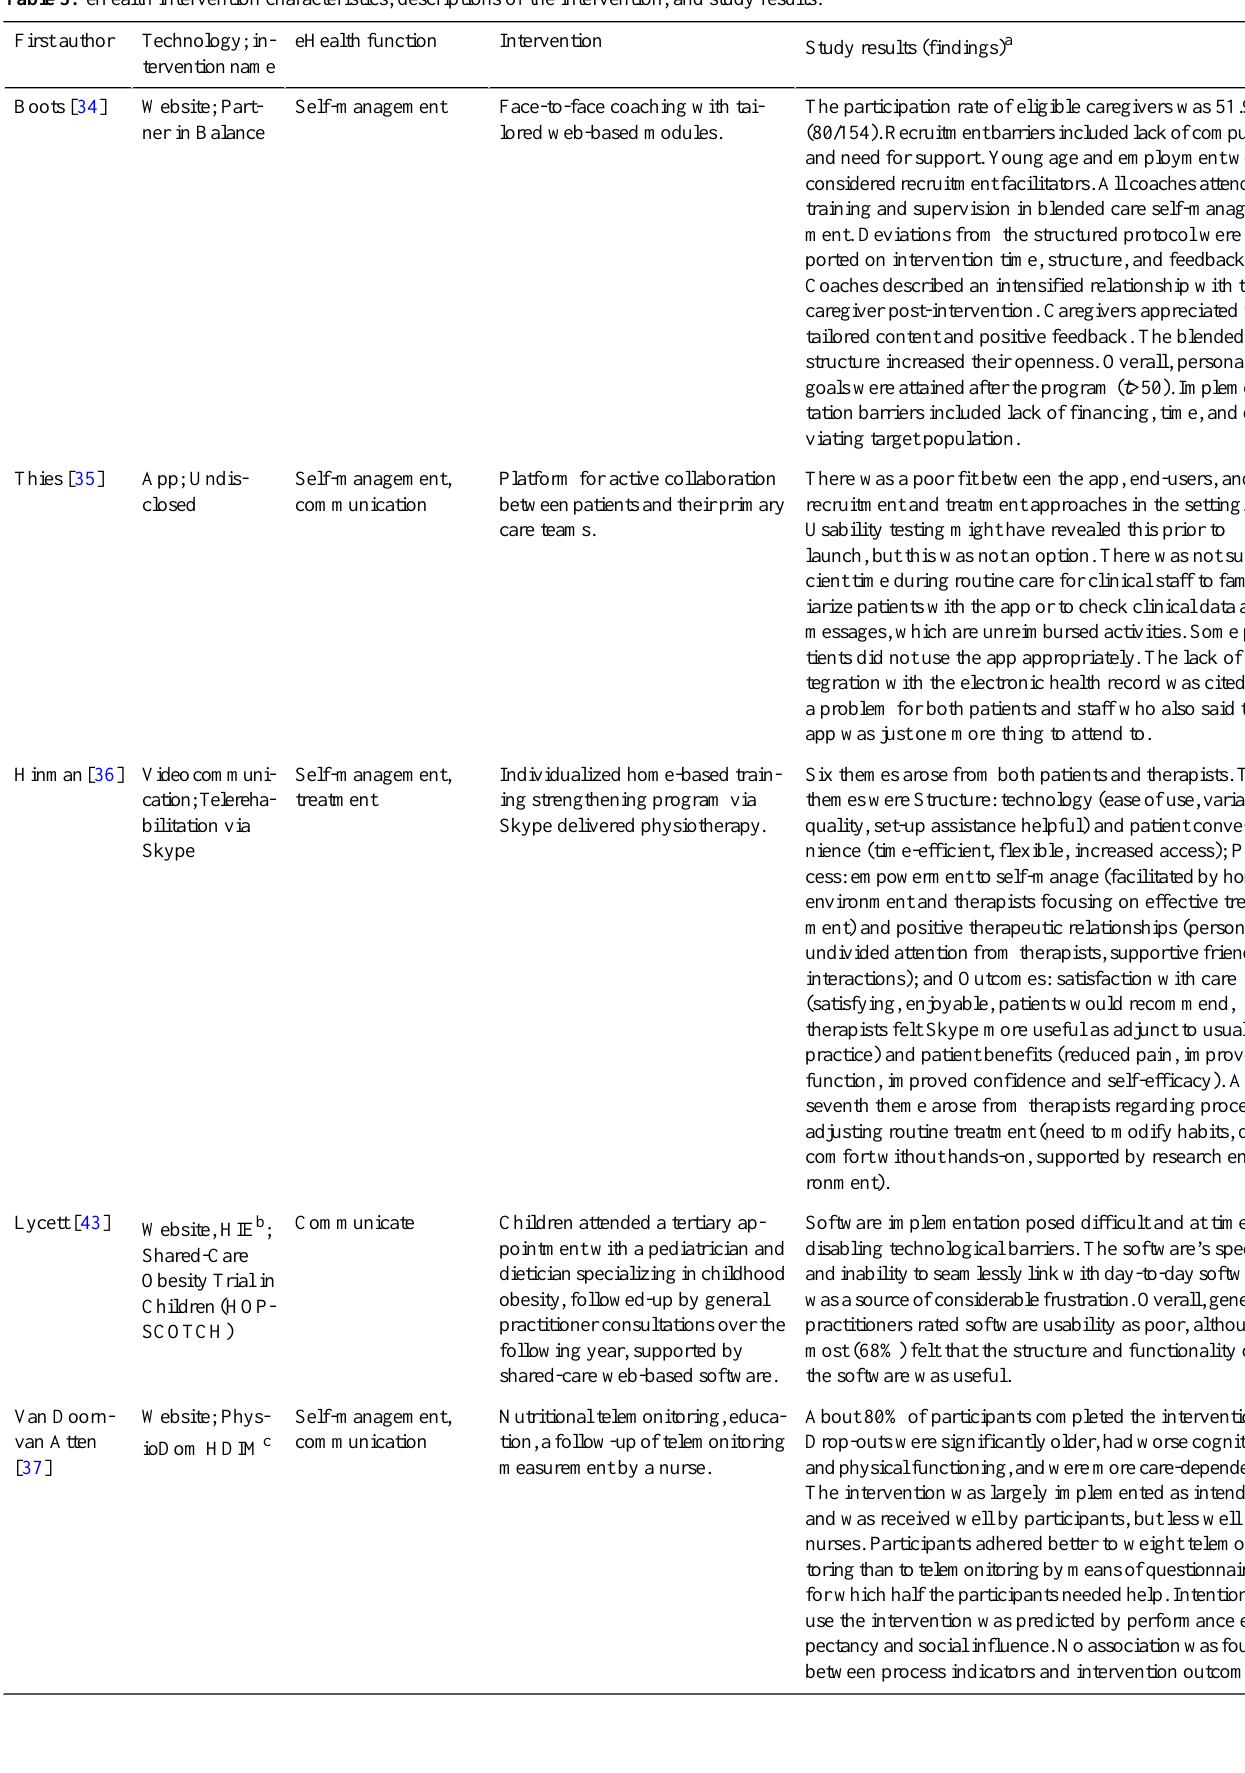
Table 3. eHealth intervention characteristics, descriptions of the intervention, and study results. nameFirst